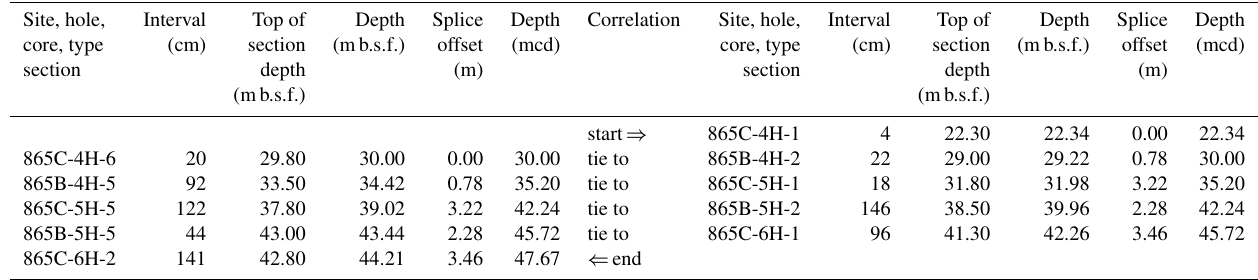
Figure 2. Sr / Ca and Ba / Sr records derived from XRF core scanning for ODP Holes 865B and 865C on the new adjusted metres composite depth (amcd) scale. Both ratios are calculated from 50kV scans. Vertical blue lines indicate positions of splice points, and the horizontal bars at bottom of the figure provide a schematic representation of the composite section. Dark shading indicates in-splice intervals of each core, and light shading indicates out-of-splice intervals of each core. Table 2. Splice tie points for ODP Site